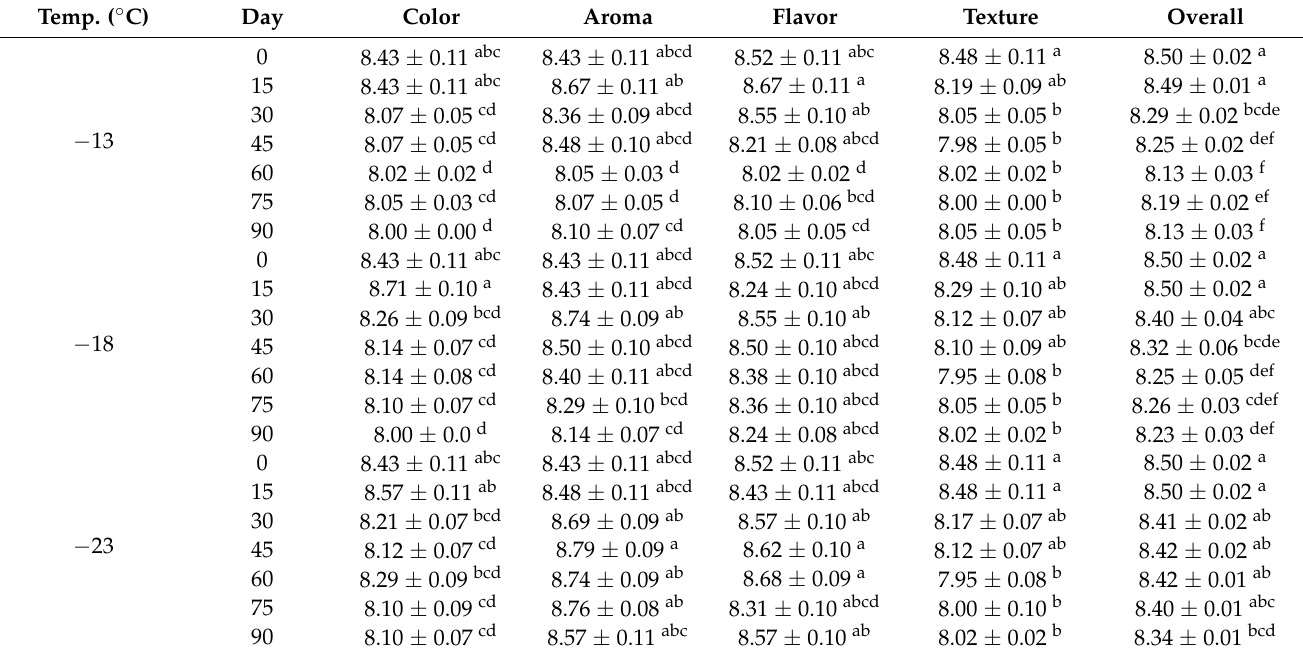
Table 10. Sensory properties of braised mackerel with radish during storage for 90 days at three different freezer temperatures. Temp. ( ◦